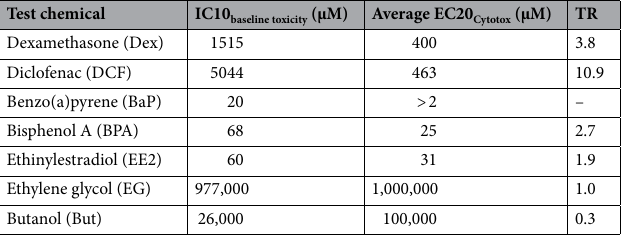
Table 3. Predicted IC10 Cytotox , average EC20 Cytotox (derived from short- and long-term exposure, without and with LPS) and the calculated toxic ratio